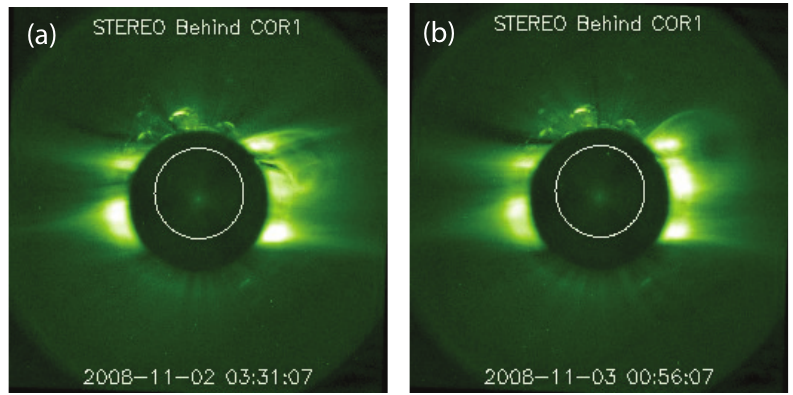
Fig. 3. Snapshot images by STB/SECCHI/COR1 of (a) CME1 on 2 November 2008 and (b) CME2 launched late 2 November 2008.